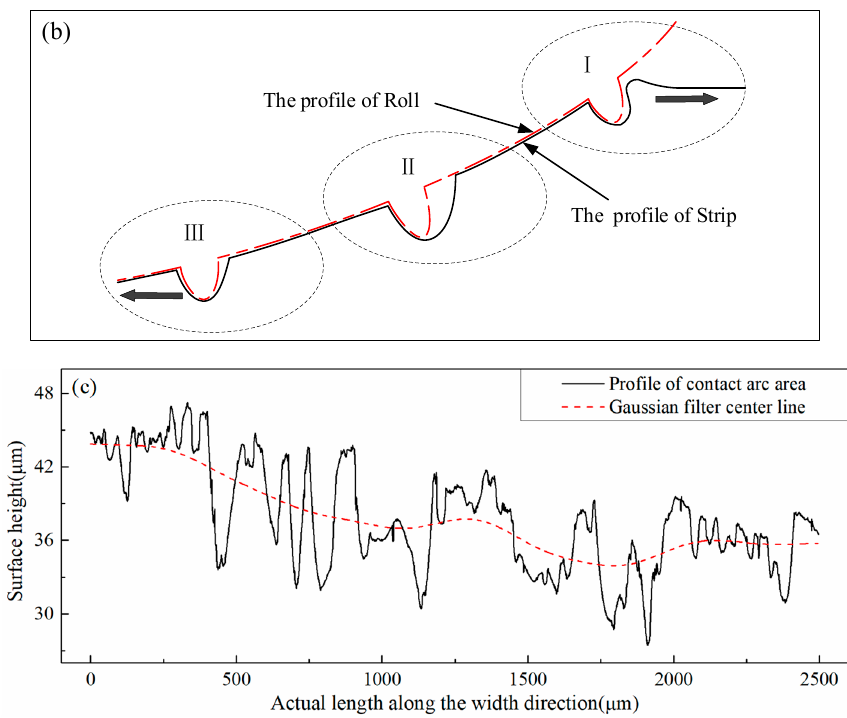
Figure 7. Surface topography of strip contact arc zone. ( a ) A 2D profile of the strip along the rolling direction. ( b ) Furrow variation in contact arc zone. ( c ) A 2D profile of the strip in the intermediate zone ( Ⅱ ) along the width direction.